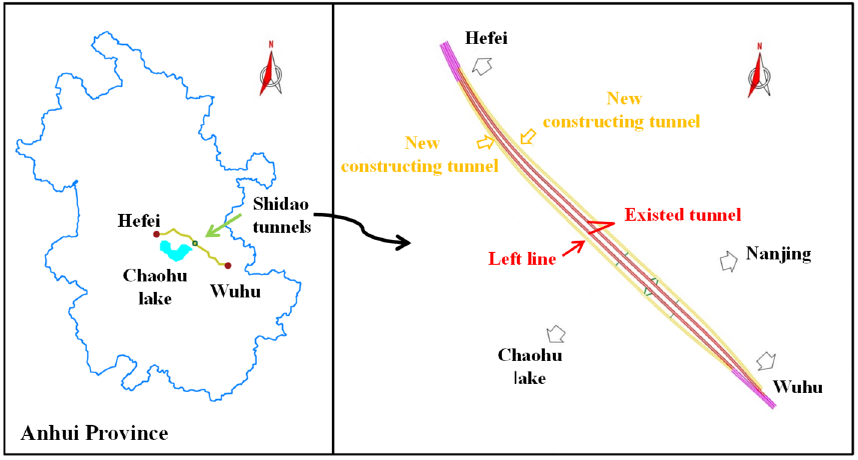
Figure 1. Location of Shidao tunnels.